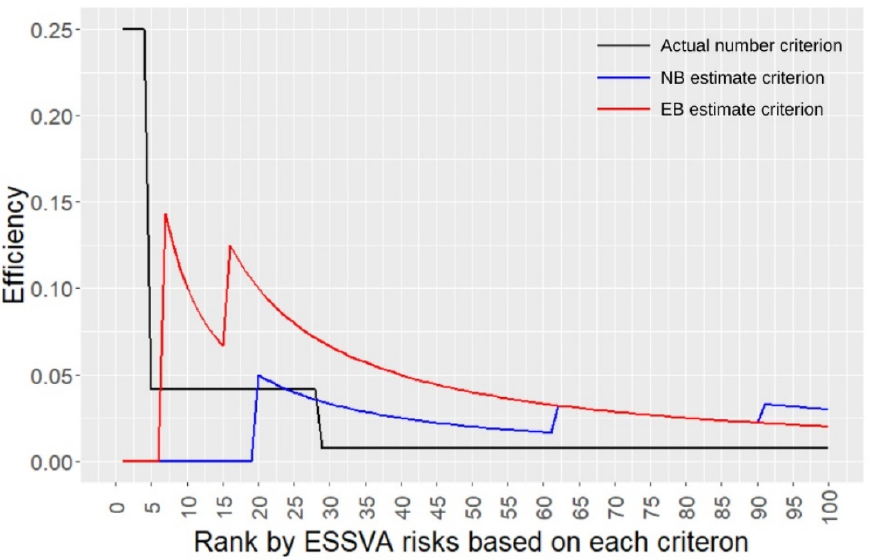
Figure 6. Comparison of the efficiencies for risky location extraction among the three